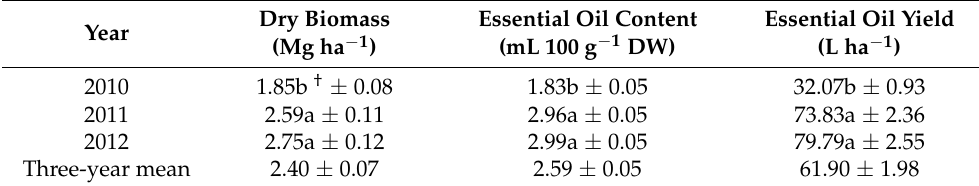
Table 3. Mean dry biomass production (Mg ha − 1 ), essential oil content (mL 100 g − 1 DW) and essential oil yield (L ha − 1 ), of all of the five Greek oregano populations combined (1-Panagia, 2- Litochoro, 3-Omolio, 4-Papadates, 5-Vytina), grown at four different nitrogen supply levels (control, N1, N2, N3, that correspond to 0, 40, 80 and 120 kg N ha − 1 , respectively), for each cultivation year and averaged for the three-year